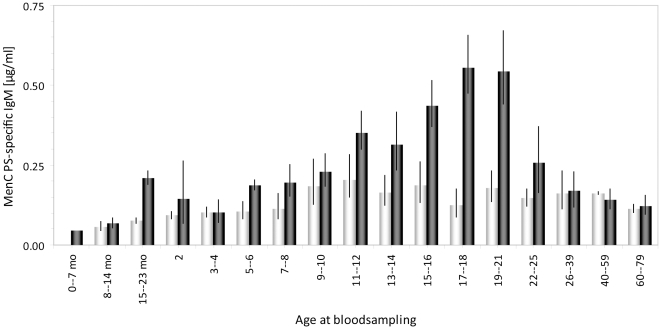
Meningococcal serogroup C PS-specific IgM levels.Levels of IgM in the pre-MenC introduction era are shown in grey bars, the post-MenC introduction era are shown in black bars. Routine immunization is offered in the post-MenC introduction era at 14 months of age and children and adolescents between 5–21 years of age received a single immunization 4–5 years earlier. Error bars indicate 95% confidence intervals. Age at bloodsampling is indicated in years or as stated otherwise (mo  =  age in months).